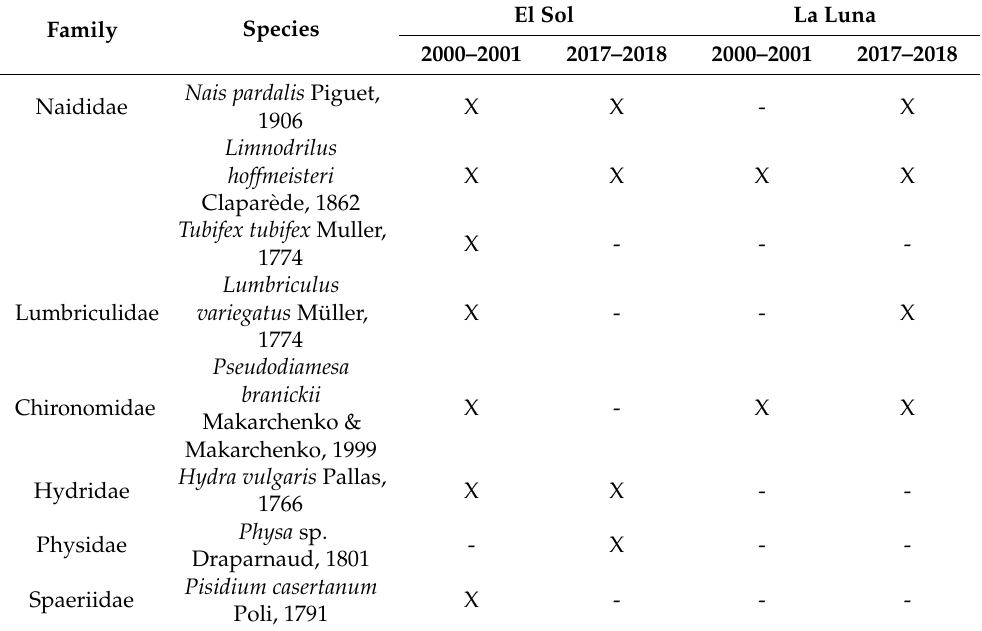
Table 2. Taxonomic list of the benthic macroinvertebrates of Lakes El Sol and La Luna, Nevado de Toluca. (X = presence, - = absence).